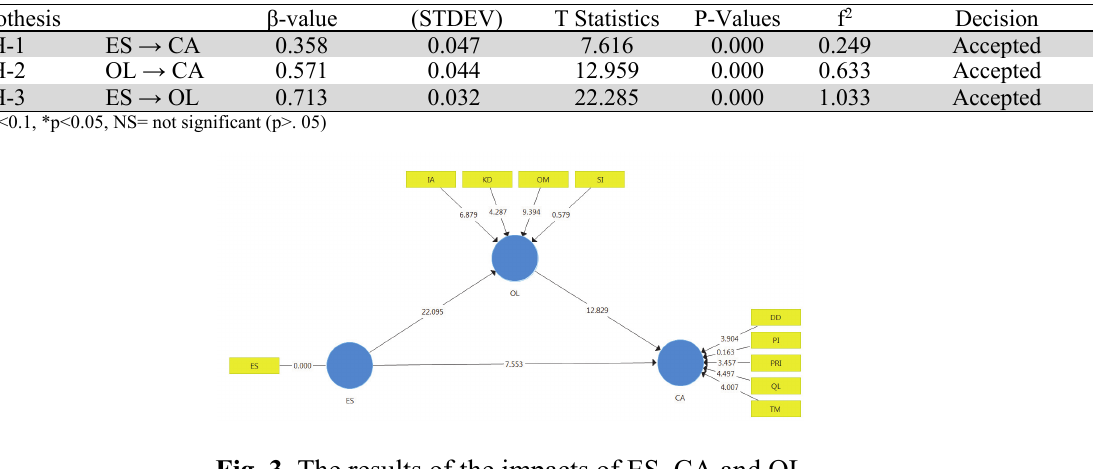
Direct Results Hypothesis